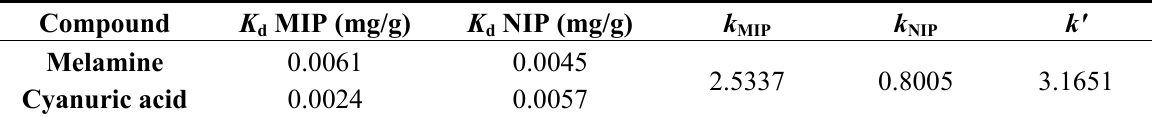
Table 3 summarized K , k and k ′ values of melamine in the presence of cyanuric acid. The k ′ value d for Mel-MIP-9VC of Melamine/cyanuric acid is 3.1651 indicating a good selectivity towards melamine [18,19]. Table 3. Selectivity study of the MIP and NIP towards melamine and cyanuric acid. Compound